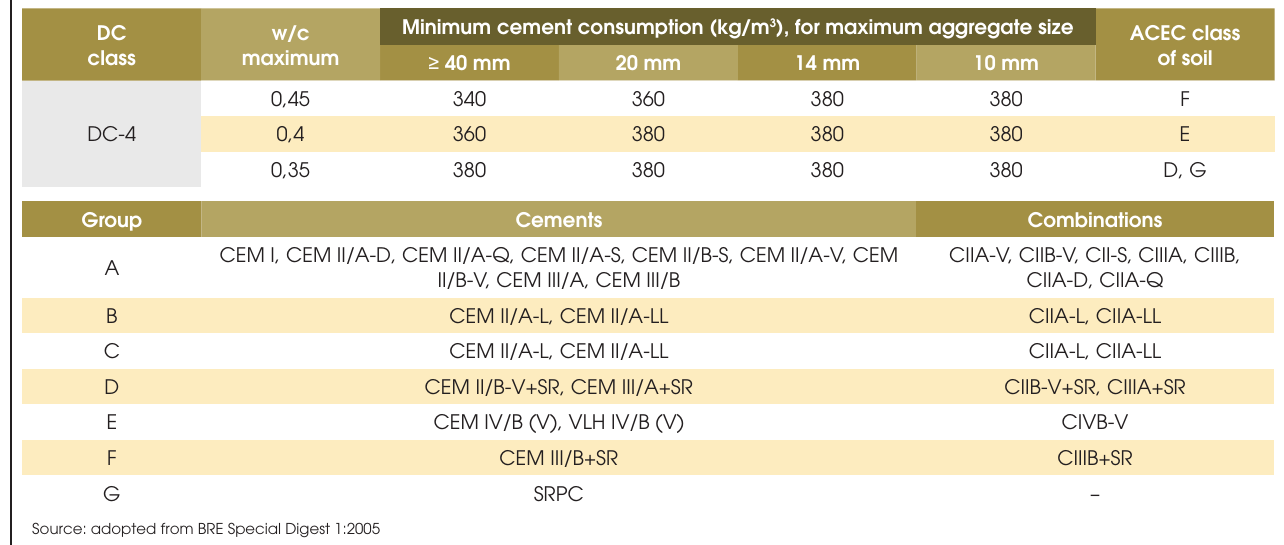
Table 10 – Concrete quality for resistance to chemical attack: concrete for general use in situ DC